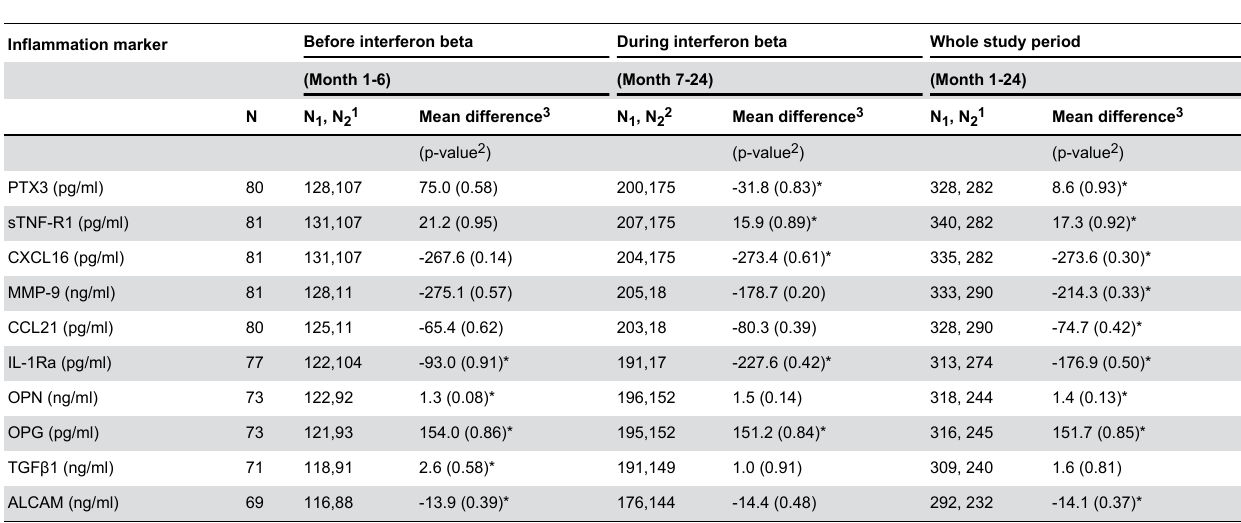
Table 5. The effect of treatment with ω-3 fatty acids versus placebo on inflammation markers.